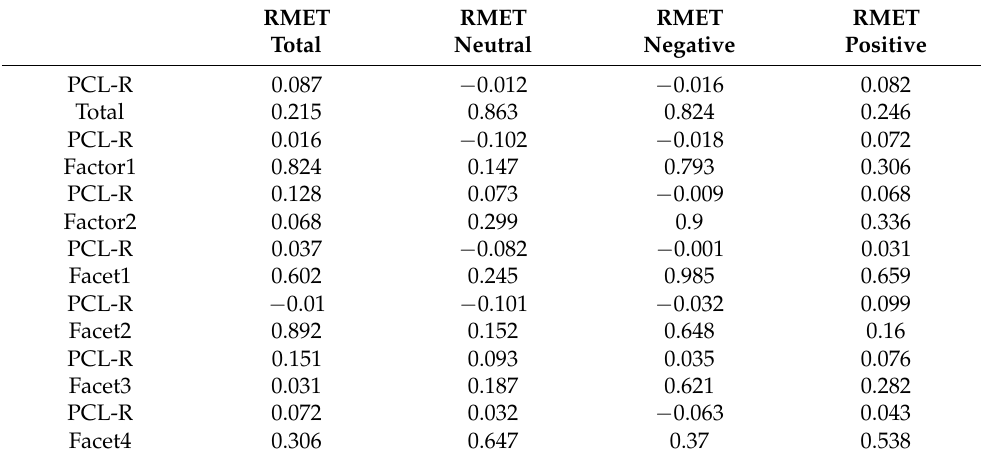
Table 1. This table shows correlations between PCL-R (Total, Factor and Facet scores) and RMET (Total, Neutral, Negative and Positive